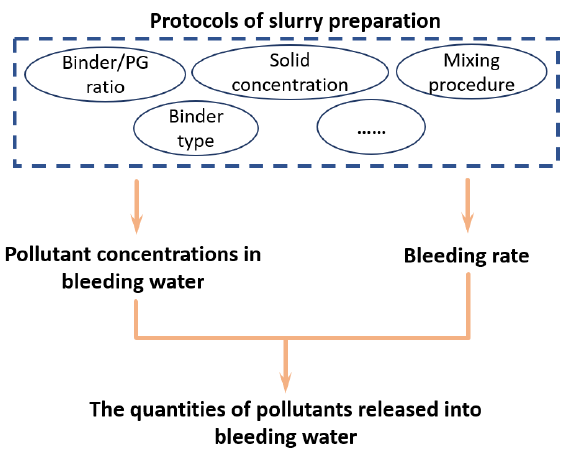
Figure 9. Schematic illustration of how the protocols for slurry preparation affected the release of pollutants from backfill slurry into bleeding water.